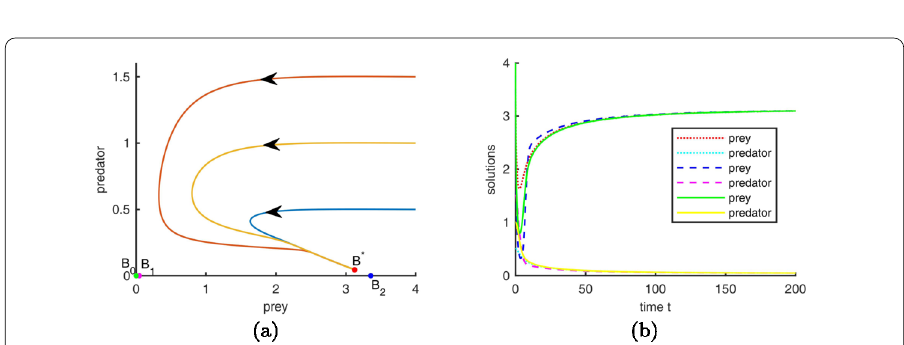
Figure 4 ( a ) The phase diagram of model (1.3) for r = 3, a = 0.1, f = 1; ( b ) solution curves for r = 3, a = 0.1, f = 1. The initial values are (4,0.5), (4,1), (4,1.5)